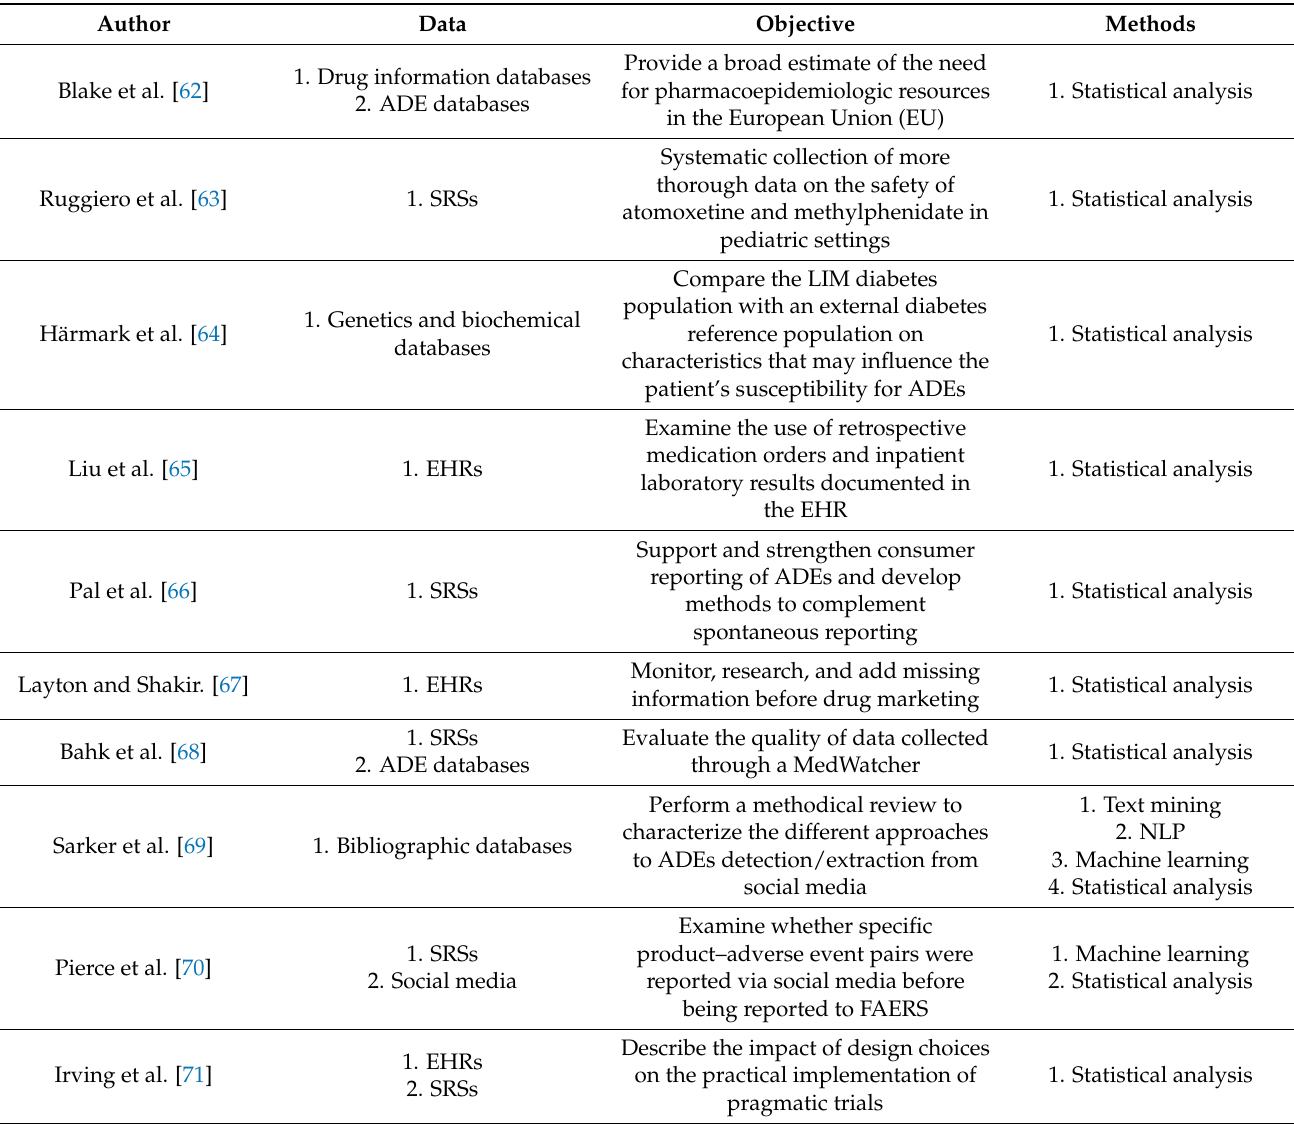
Table 5. List of papers for monitoring ADR and managing patient